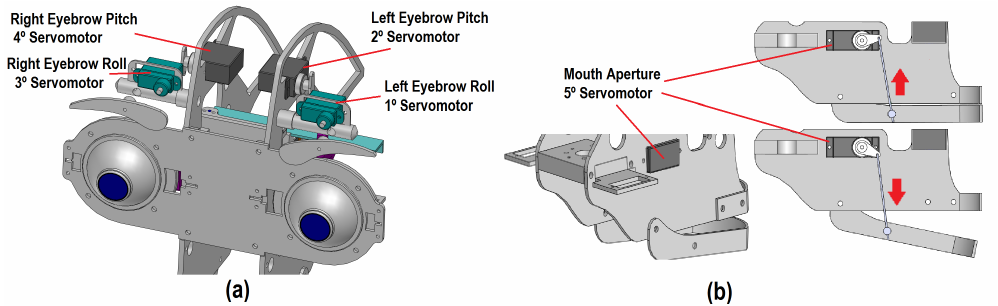
Figure 4. Configuration of the eyebrows and the mouth